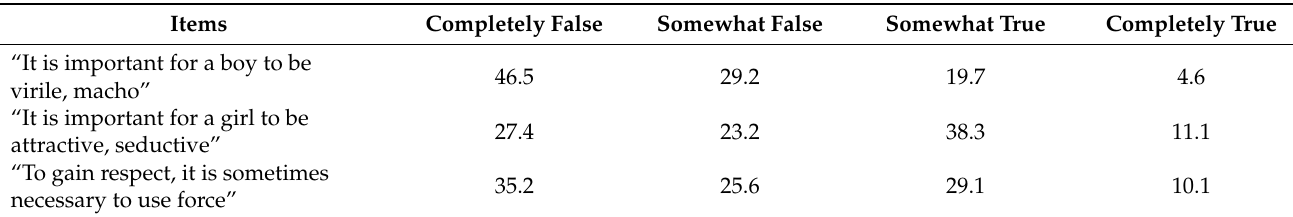
Table 2. Frequency table for participants’ opinion on gender stereotypes and the acceptance of violence